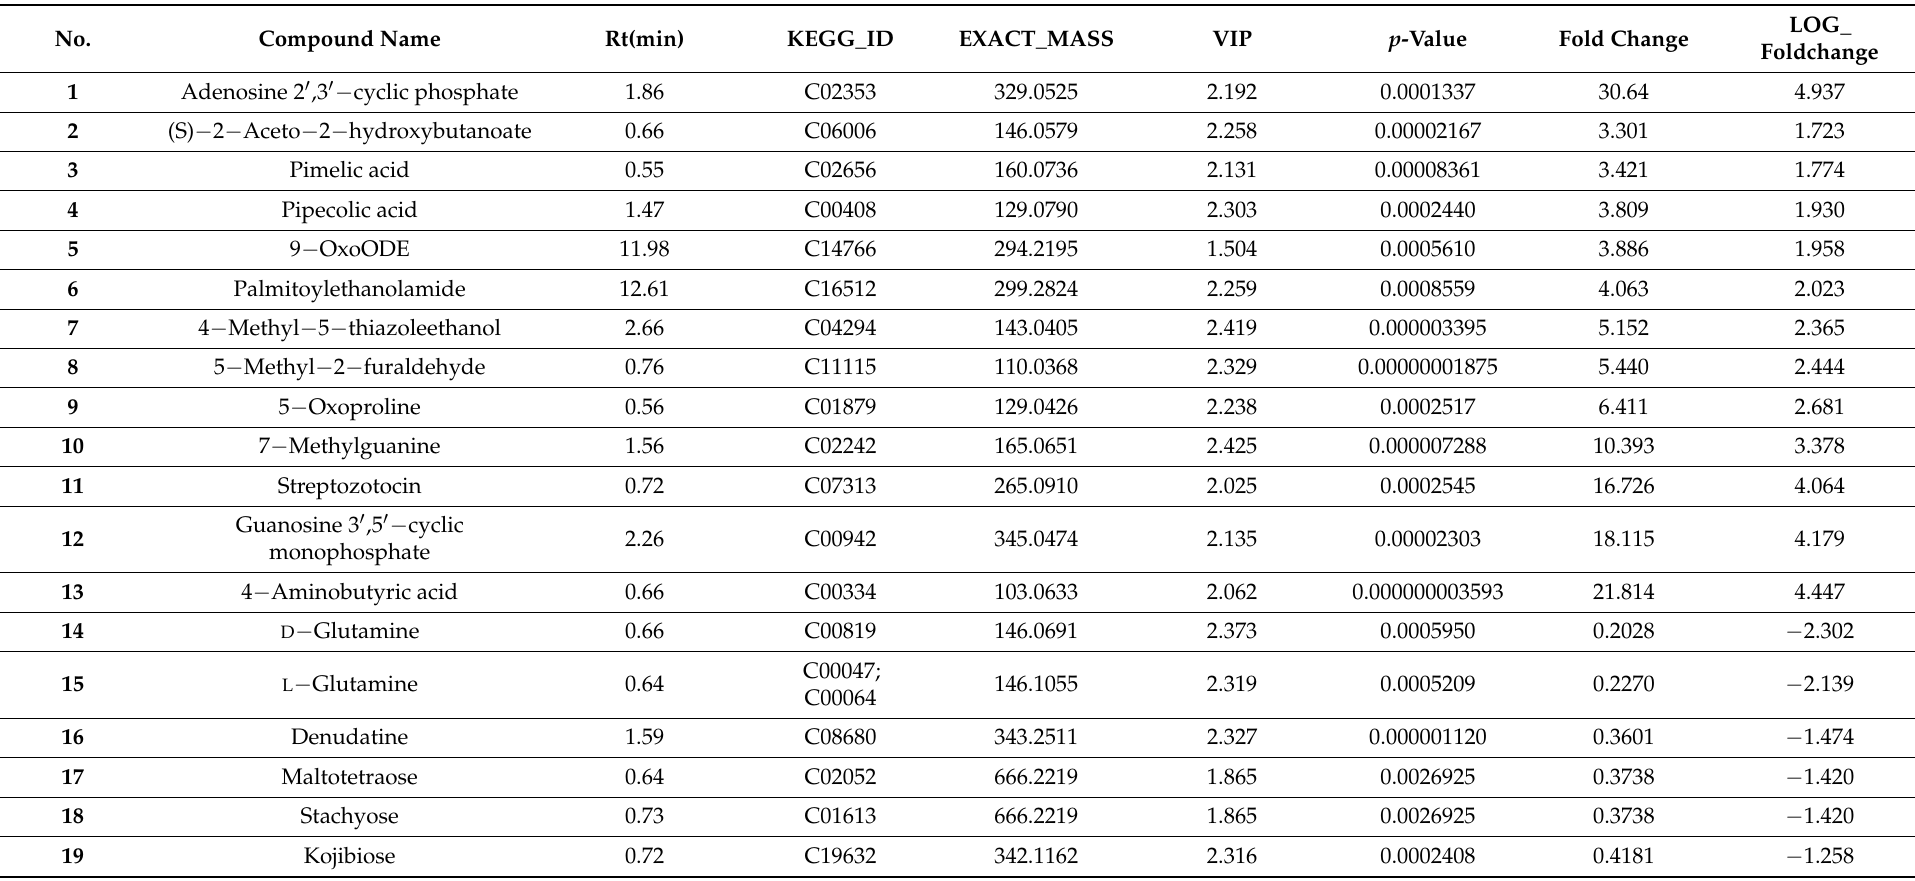
Table 1. Key differential metabolites in HT_6